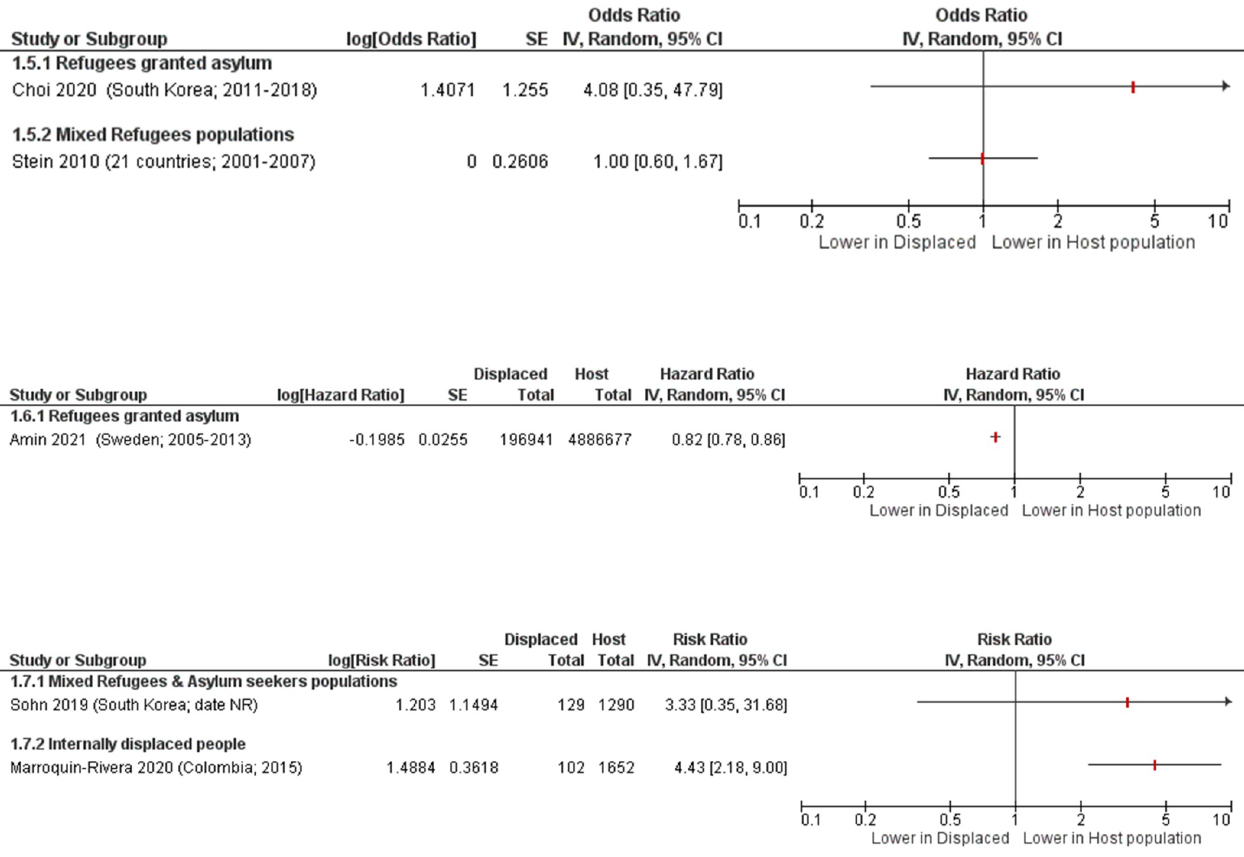
Fig 3. Suicide attempts in displaced people compared to host population forest plots, grouped by outcome measure and then sub-grouped by population type. Choi 2020 [30] adjusted for interview year; Stein 2010 [81] adjusted for person-year, country, demographic factors (age, sex, time-varying education, time-varying marriage), interactions between life course and demographic variables, parent psychopathology, and childhood adversities; Amin 2021 [20] adjusted for socio-demographic, labour market marginalisation and morbidity factors (i.e. sex, age, educational level, family situation and type of residential area, days with full-time unemployment, net days with sickness absence, granted disability pension, history of suicide attempt; history of inpatient or specialised outpatient healthcare); Sohn 2019 [77] age- and gender-matched; Marroquin-Rivera 2020 [54] unadjusted.